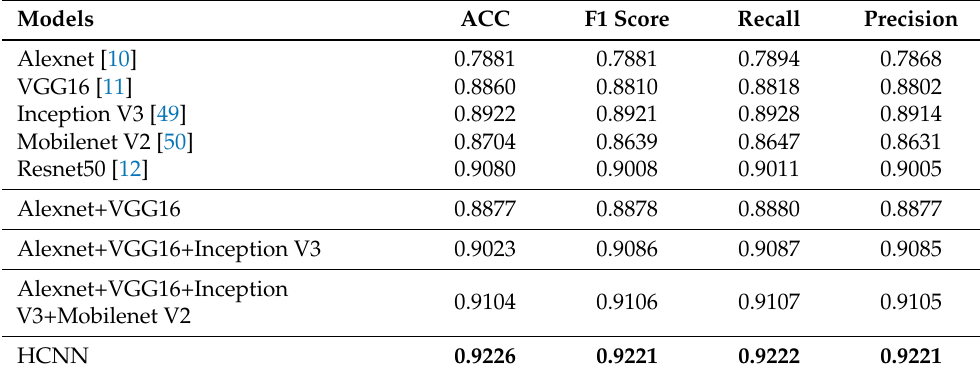
Table 4. The ablation analysis on the CIFAR-10